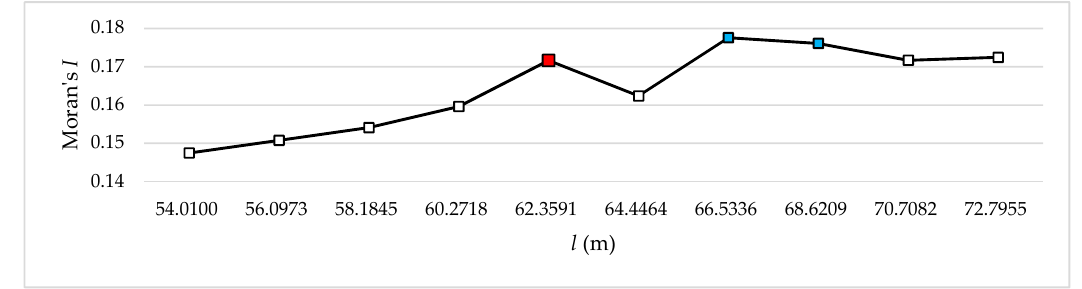
Figure 8. Changes of Moran’s I according to the cluster size at level 13.